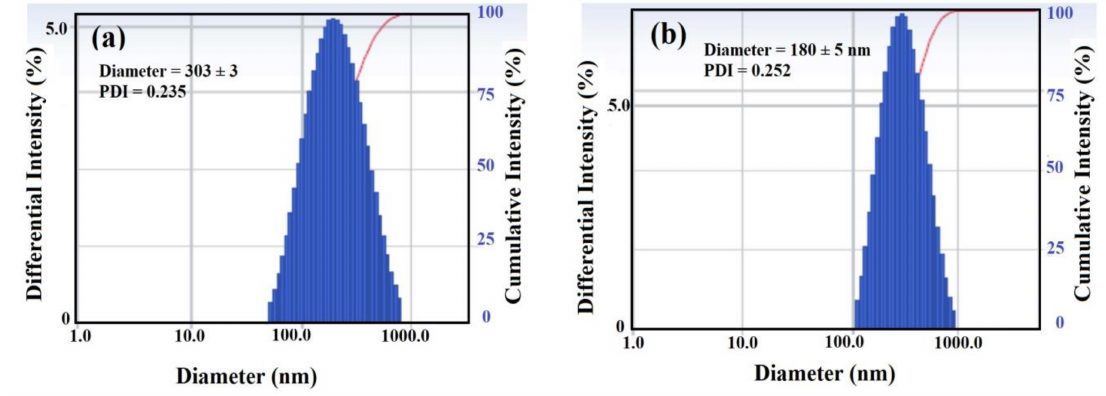
Figure 7. Dynamic light scattering (DLS) of ( a ) DCHI-Fe 3 O 4 and ( b ) HPHI-Fe 3 O 4 . PDI, polydispersity